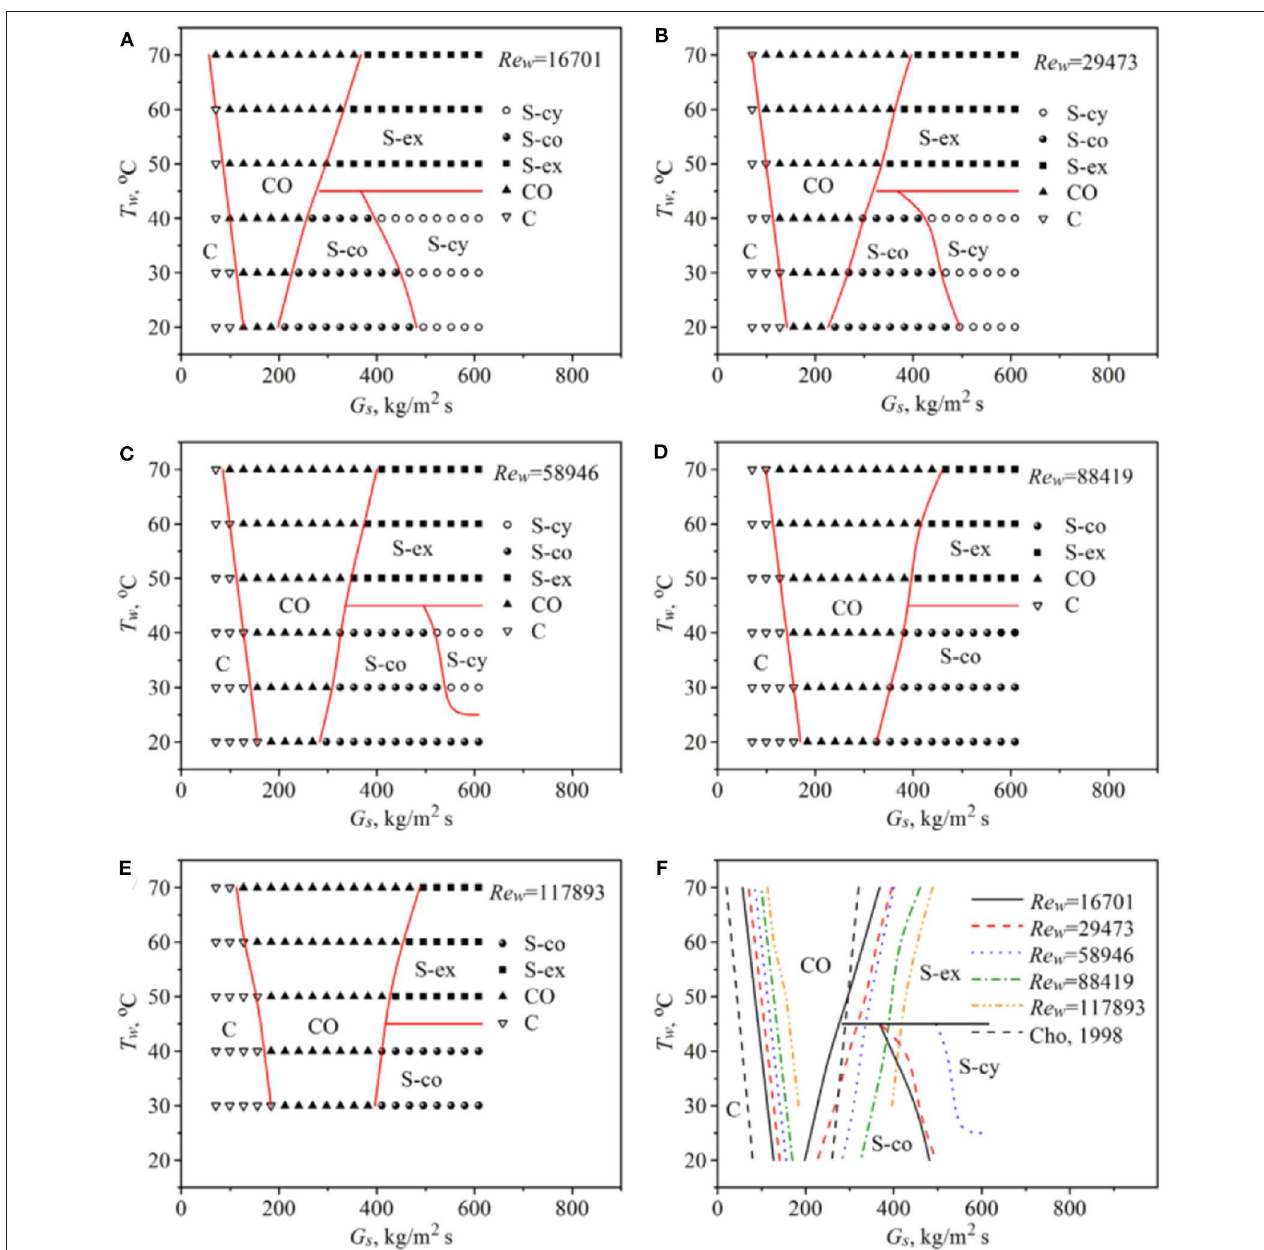
FIGURE 9 | The planar regime maps developed by Xu and Guo (2016). (A) Re = 16,701; (B) Re = 29,473; (C) Re = 58,946; (D) Re = 88,419; (E) Re = 117,893; (F) transition lines for different Re.